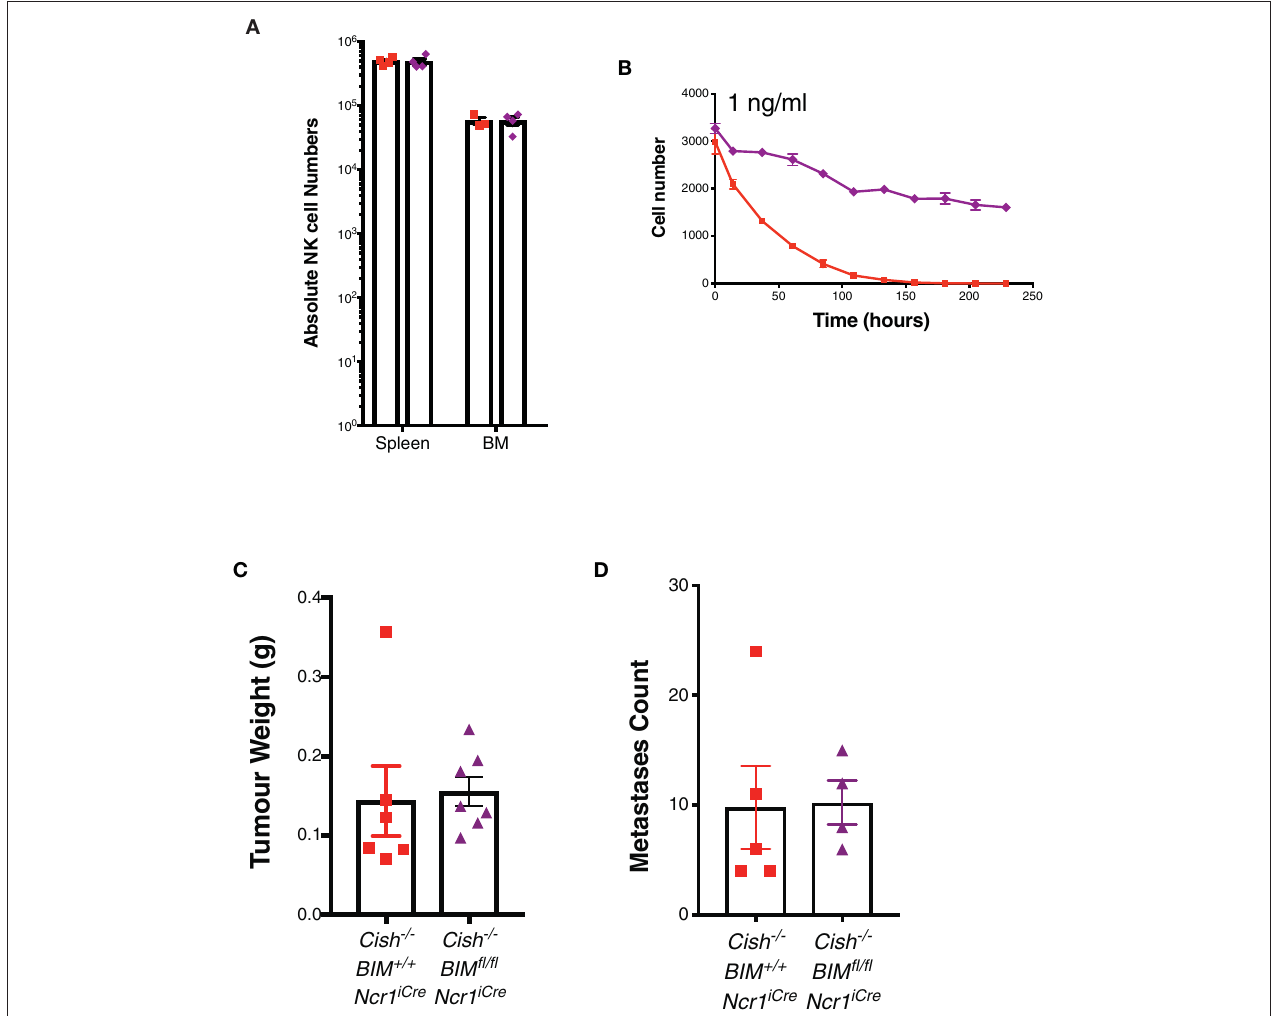
FIGURE 4 | Loss of the pro-apoptotic protein, BIM, does not alter the homeostatic expansion or anti-tumor function of Cish -deficient NK cells. (A) Absolute numbers of NK cells in the spleen and BM of 6–8 week old female Cish − / − Bim + / + Ncr1 + / + , Cish + / + Bim fl / fl Ncr1 KI / + , and Cish − / − Bim fl / fl Ncr1 KI / + mice were quantified by flow cytometric analysis. (B) Purified and CTV-labeled Cish − / − Bim + / + Ncr1 iCre , and Cish − / − Bim fl / fl Ncr1 iCre NK cells were seeded at 1 × 10 4 cells/well into round